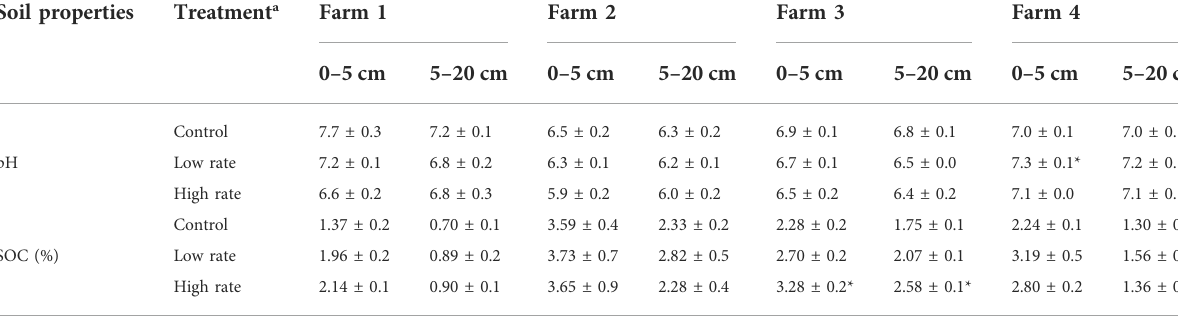
TABLE 2 Effect of organic matter application on the selected soil properties in the different fi eld trials. Soil properties